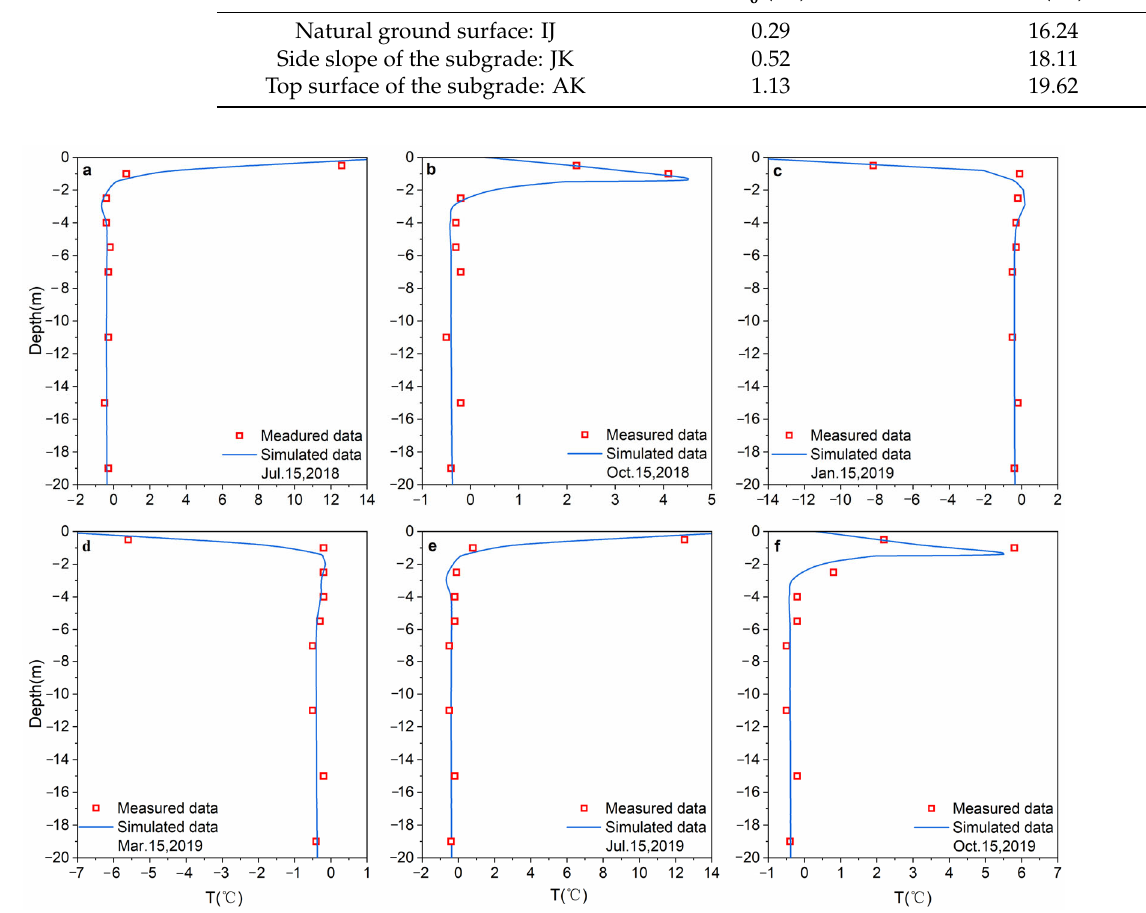
Figure 5. Comparison between the measured and simulated ground temperature values at the 1 m borehole outside the right slope toe from July 2018 to October 2019: ( a ) 15 July 2018, ( b ) 15 October 2018, ( c ) 15 January 2019, ( d ) 15 March 2019, ( e ) 15 July 2019, and ( f ) 15 October 2019.